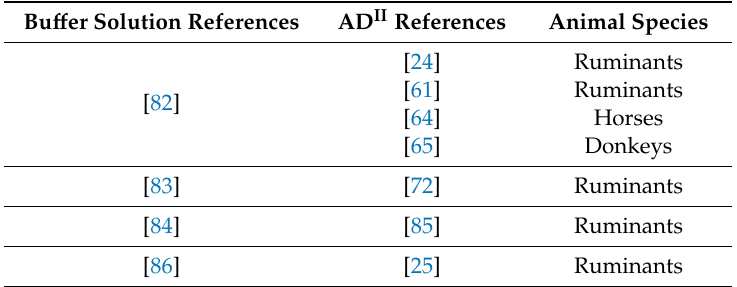
Table 3. Di ff erent bu ff er solutions used in in vitro digestibility trials with the Ankom Daisy II incubator (AD II ) in di ff erent animal